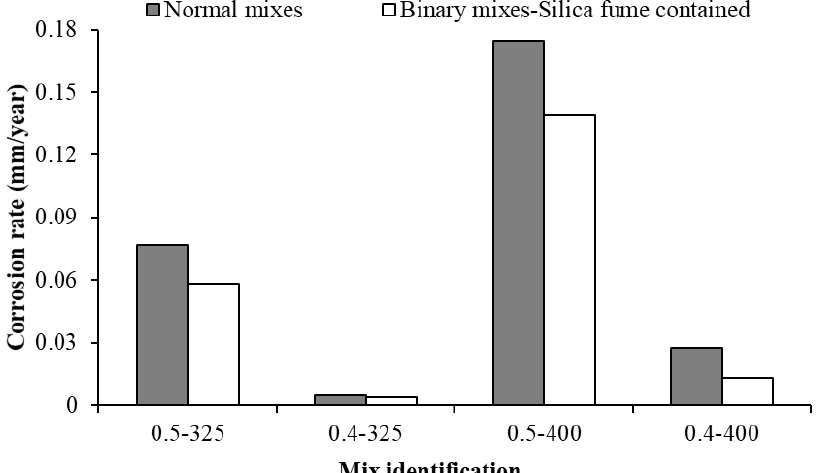
Fig. 4. One-year reinforcement’ corrosion rate of the selected mixes measured by potentiodynamic